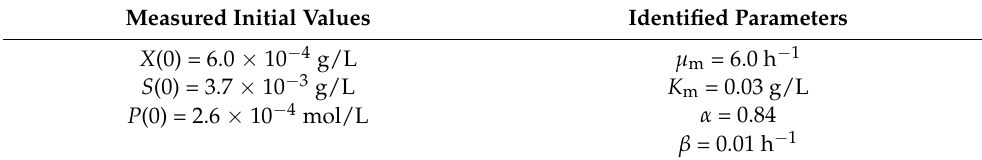
Table 1. Measured initial values and identified parameters of the constant temperature model.